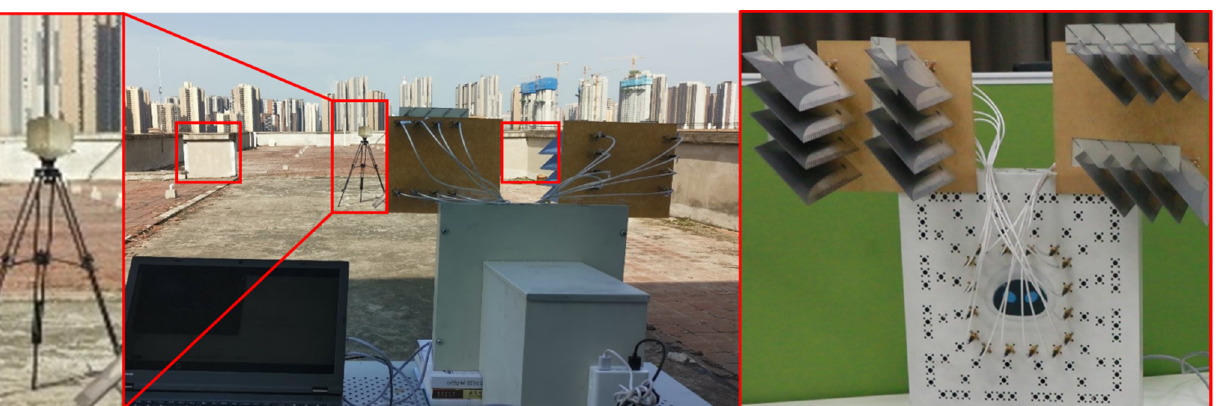
. Figure 28. SDR-MIMO radar array structure and imaging geometry. To mimic the MIMO radar considered in this paper for target imaging under WBI, the pre-processed signal shown in (38) is phase modulated, giving , , 2